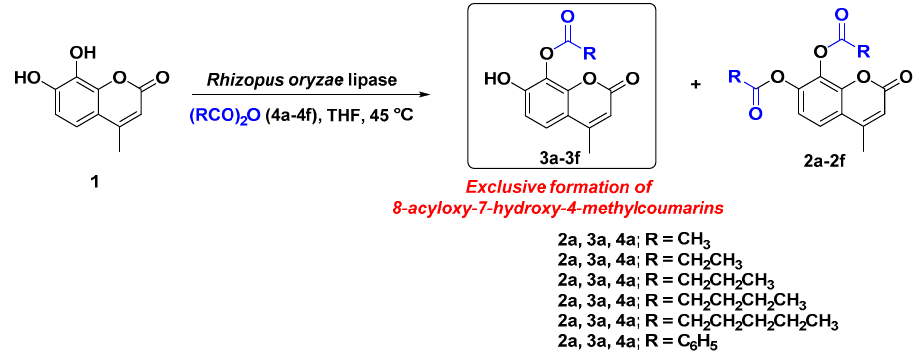
Table 1. Rhizopus oryzae lipase (ROL)-catalyzed regioselective formation of 8-acyloxy-7-hydroxy-4-